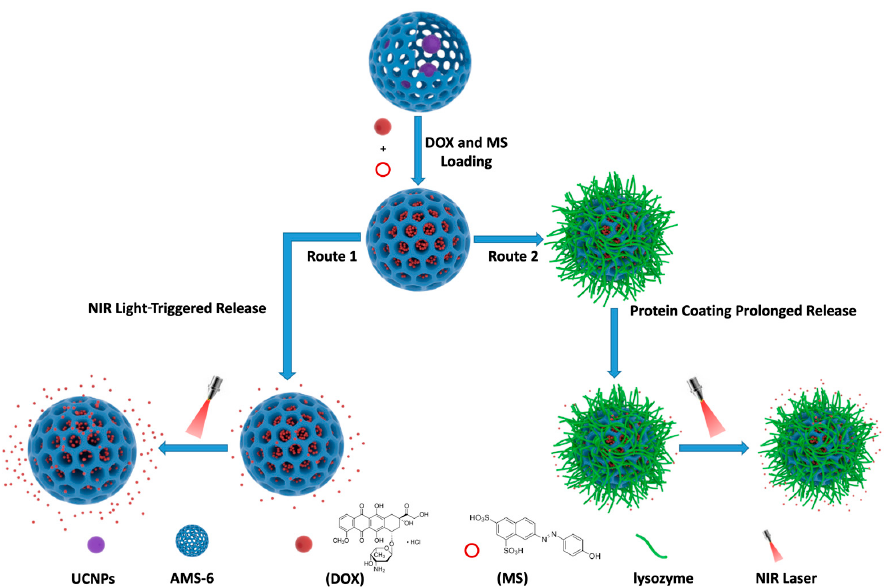
Scheme 1. Schematic illustration of the lysozyme and NIR light-responsive dual-function DRSs system. Drug (doxorubicin, DOX) and molecule stirrer (MS) are entrapped within the mesopores